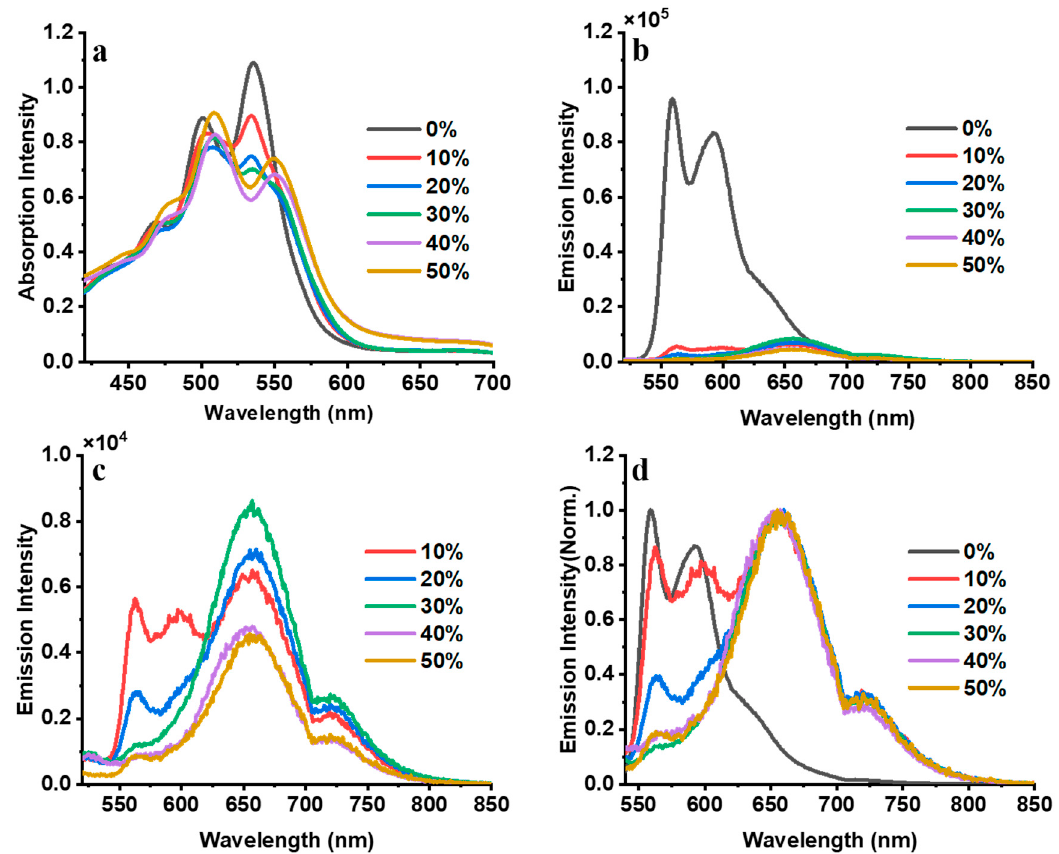
Figure 3. The absorption ( a ) and fluorescence ( b ) spectra of PDI-III with different water concentra- tions; the fluorescence ( c ) and normalized fluorescence spectra ( d ) of PDI-III with different water concentrations (0% water is excluded).